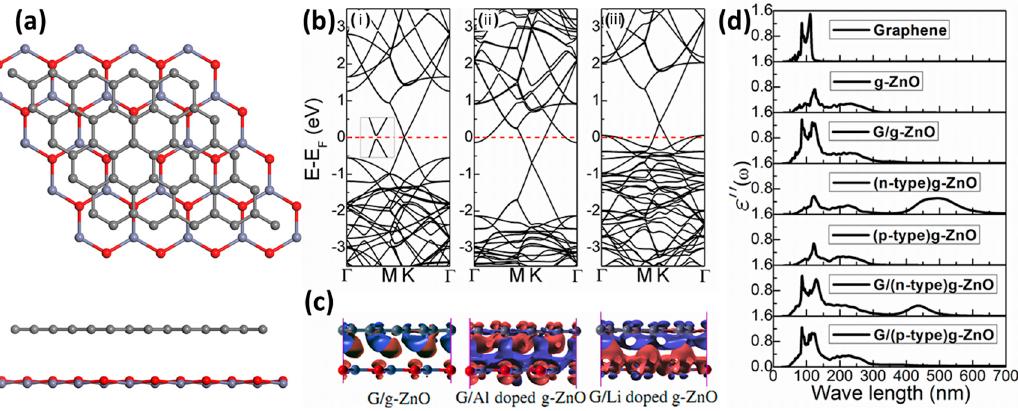
Figure 8. ( a ) Top and side views of stick and ball model of G/g-ZnO heterojunctions structures. The grey, blue and red balls represent carbon, zinc and oxygen atoms, respectively. ( b ) From left to right, energy band structures of G/g-ZnO, G/Al-doped g-ZnO, and G/Li-doped g-ZnO heterojunctions, respectively. The zero of energy is set at the Fermi level (red dash lines). ( c ) From left to right, charge density distribution of G/g-ZnO, G/Al-doped g-ZnO, and G/Li-doped g-ZnO heterojunctions. The red and blue puddles indicate electron increase and decrease, respectively. ( d ) From top to bottom, imaginary part (ϵ") of dielectric function (perpendicular to the surface) for graphene, g-ZnO mono-layers and G/g-ZnO stacking. Figure 8b–d kindly provided by W. Hu.